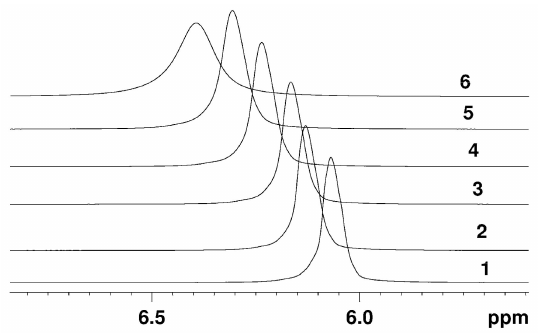
Figure 5. 1 H NMR spectra in acid ionic form of Nafion membranes at different temperatures. Mem- brane samples were equilibrated with water vapor at 58% relative humidity. (1) +25 ◦ C; (2) +10 ◦ C; (3)0 ◦ C; (4) − 20 ◦ C; (5) − 40 ◦ C; (6) − 60 ◦ C. Reprinted with permission from [25]. Copyright 2019 Springer